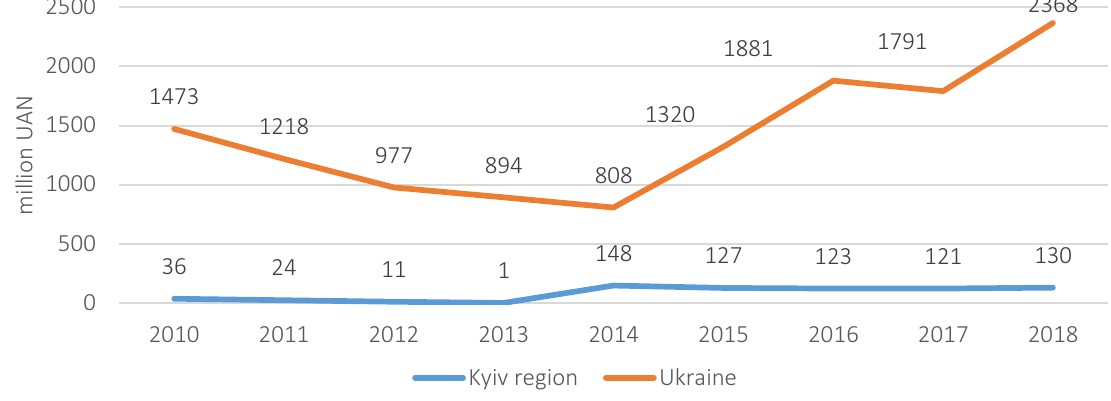
Figure 2. The dynamics of arrears of wages in the Kyiv region and in Ukraine during